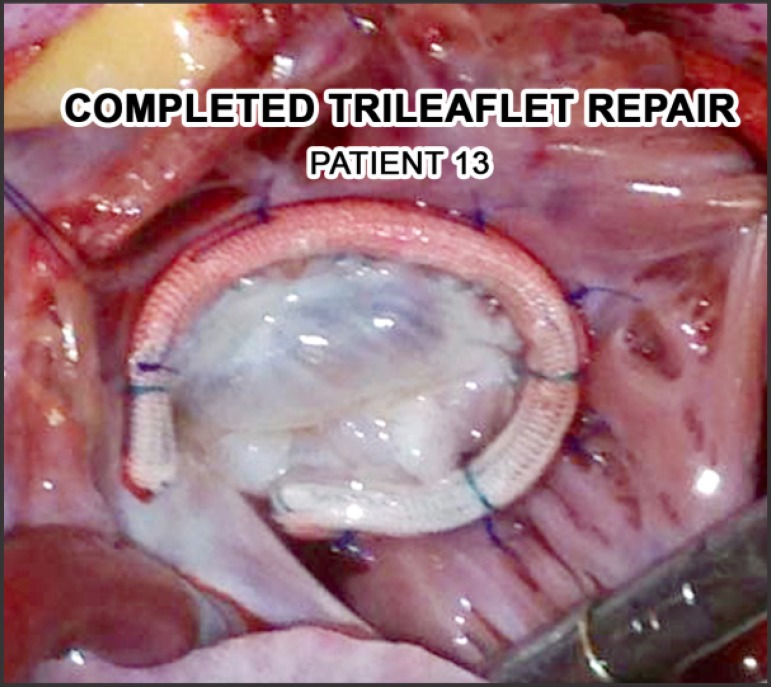
Intraoperative photograph of a completed Ebstein's repair showing
neoannulus supported by a 3D ring and competent trileaflet
repair.